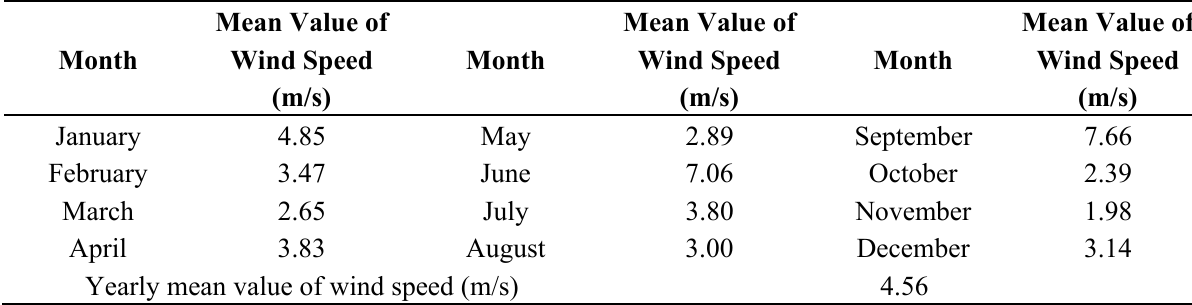
Table 2. Monthly and annual mean values of observed wind speed.